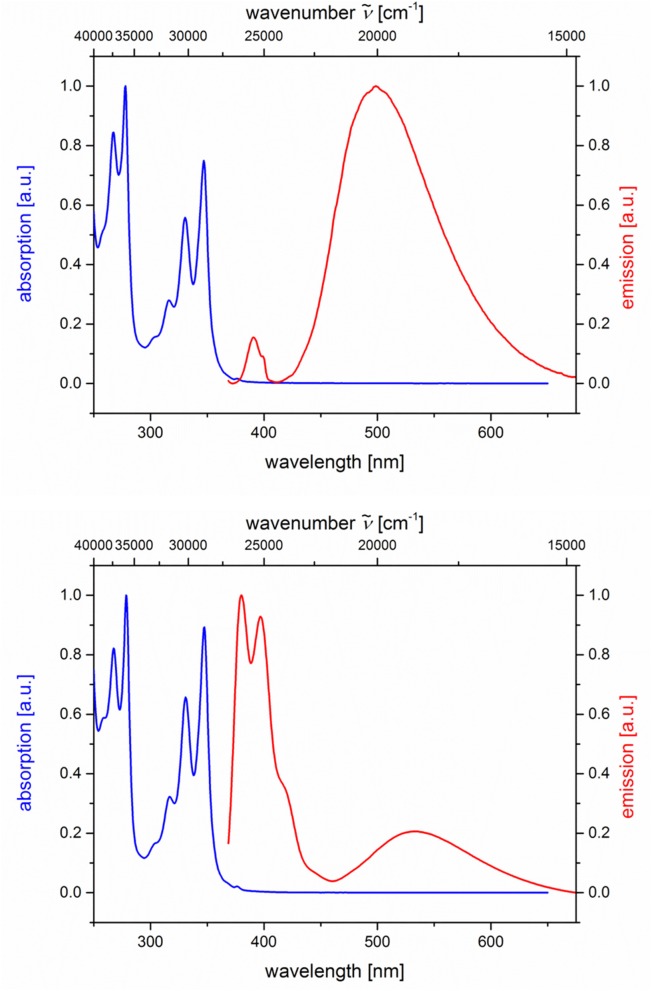
Normalized absorption (blue lines) and emission (red lines) spectra of compounds 5i (top) and 5j (bottom) (recorded in CH2Cl2 (chromasolv), T = 298 K, λexc = 348 nm).